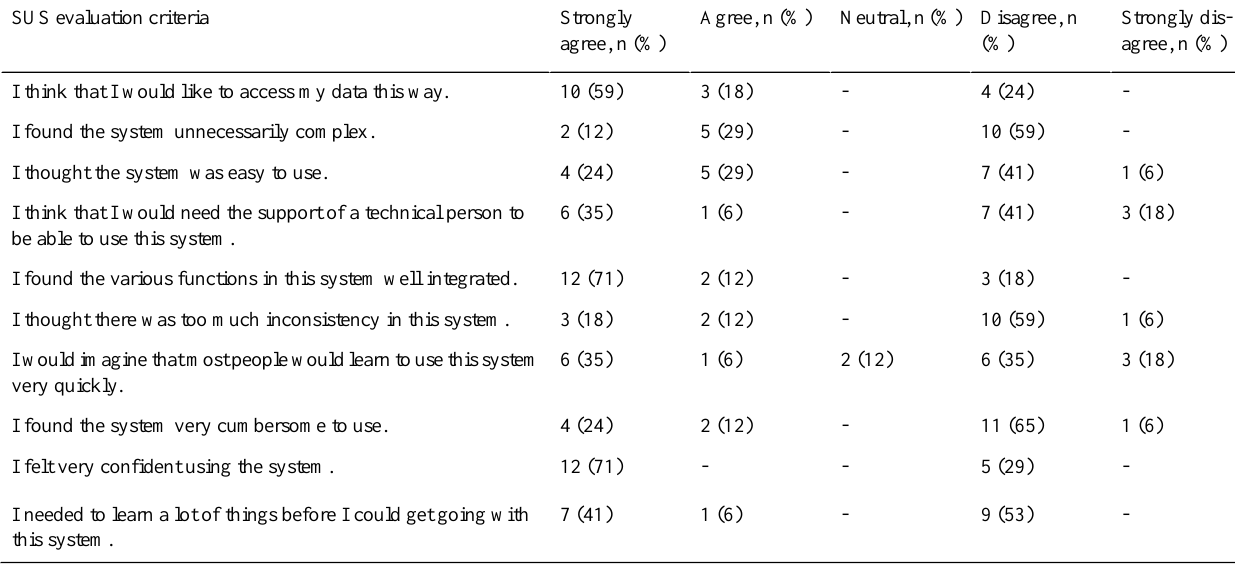
Table 2. . SUS evaluation criteria and participant response (n=17).